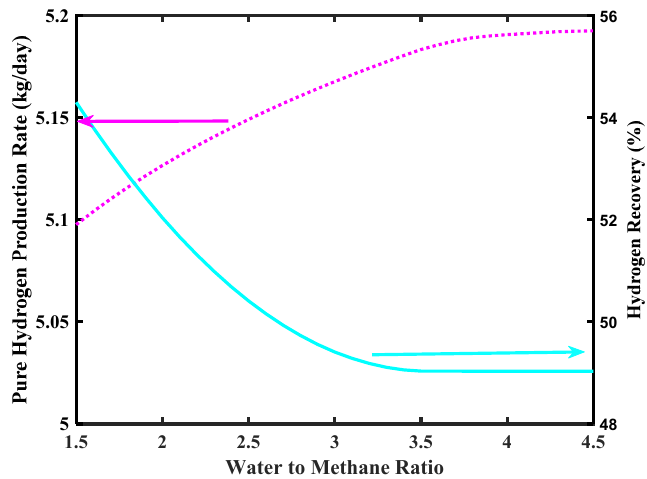
Figure 9. Pure H 2 production rate and hydrogen recovery ratio versus water to methane ratio, Pd-Ag membrane thickness = 50 µm, inlet temperature = 500 °C, and inlet pressure = 10 bar.